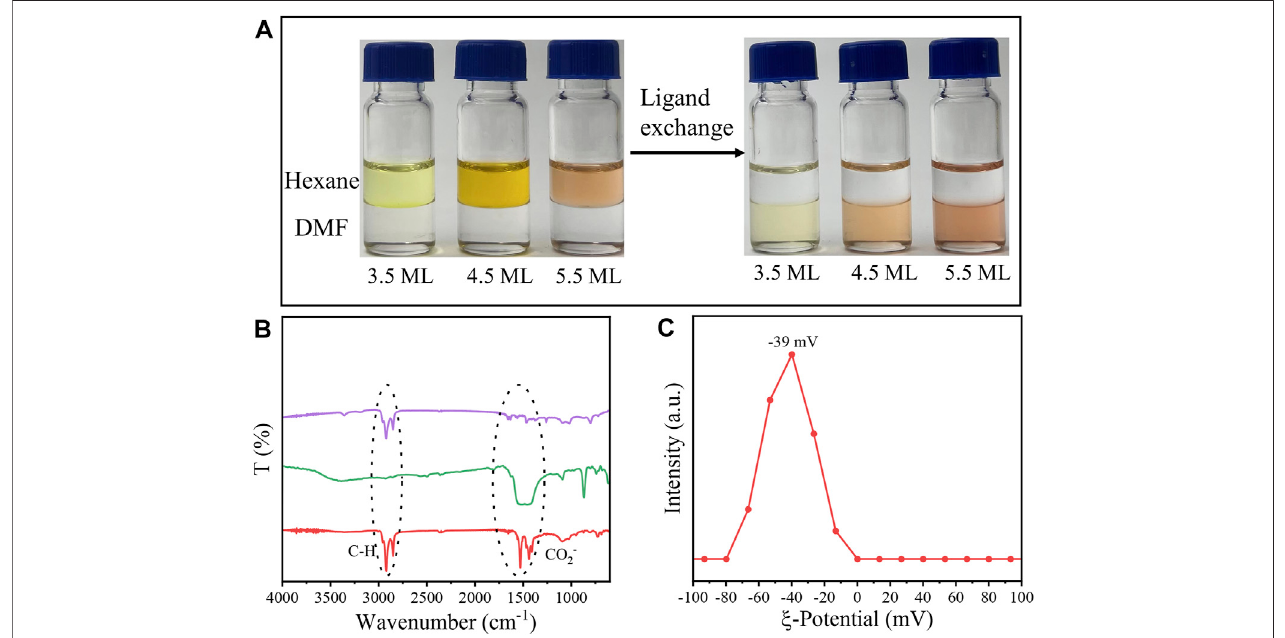
FIGURE1|(A) DifferentmonolayerCdSeNPLsundergophasetransferfromhexanetoDMF. (B) FT-IRspectra(red:originalNPLs,green:NPLscappedwithTEB, purple: supernatant after ligand exchange). (C) Zeta potential for NPLs capped with TEB.